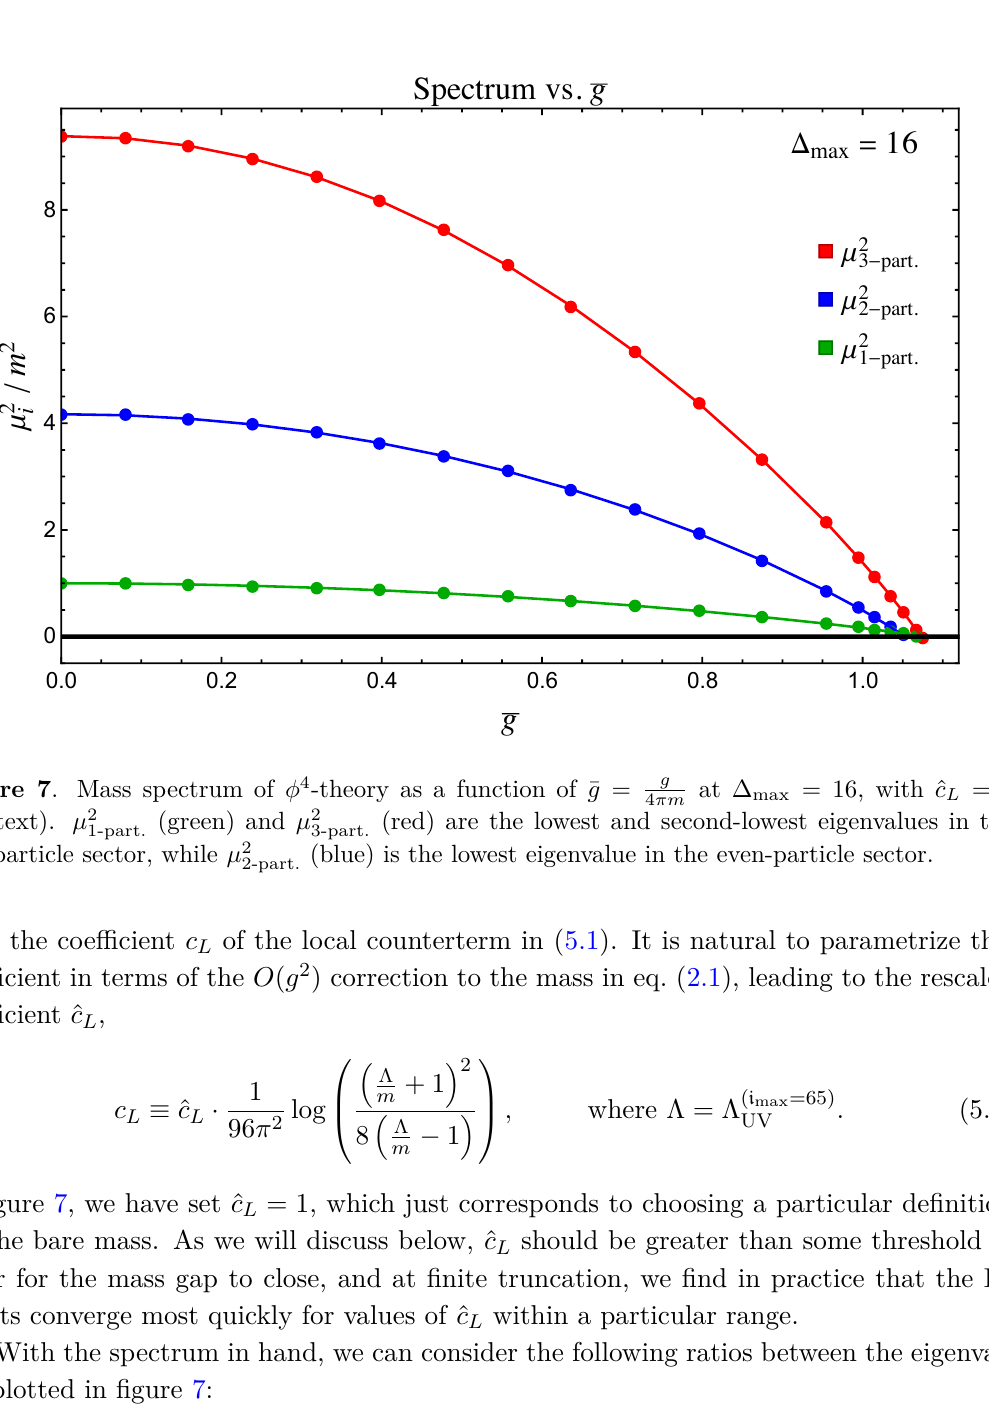
Figure 7 . Mass spectrum of φ 4 -theory as a function of ¯ g = g (see text). µ 2 (green) and µ 2 (red) are the lowest and second-lowest eigenvalues in 1 -part. 3 -part.